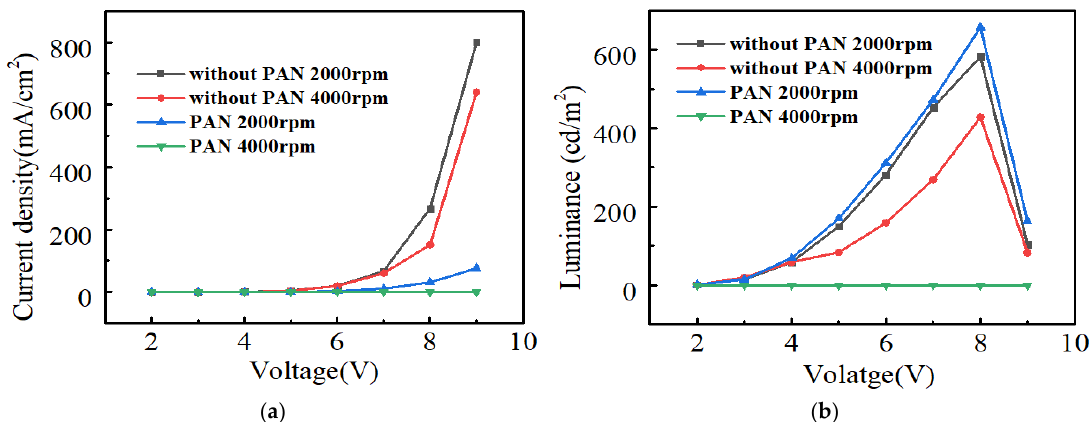
Figure 5 . Current–luminance–voltage (I–L–V) characteristic curve of a red PeLED: ( a ) Current density–voltage (J–V) curve; ( b ) luminance–voltage (L–V) curve.